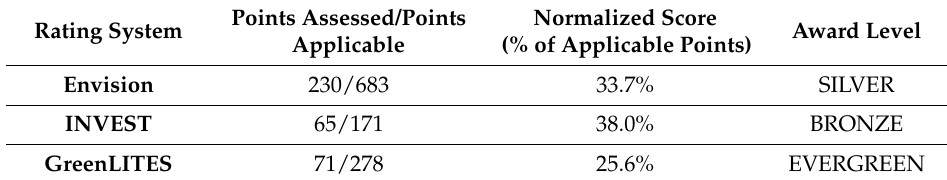
Table 2. Project 1 (cid:48) s normalized score and award level on each rating system. Table 2. Project 1 ′ s normalized score and award level on each rating system.